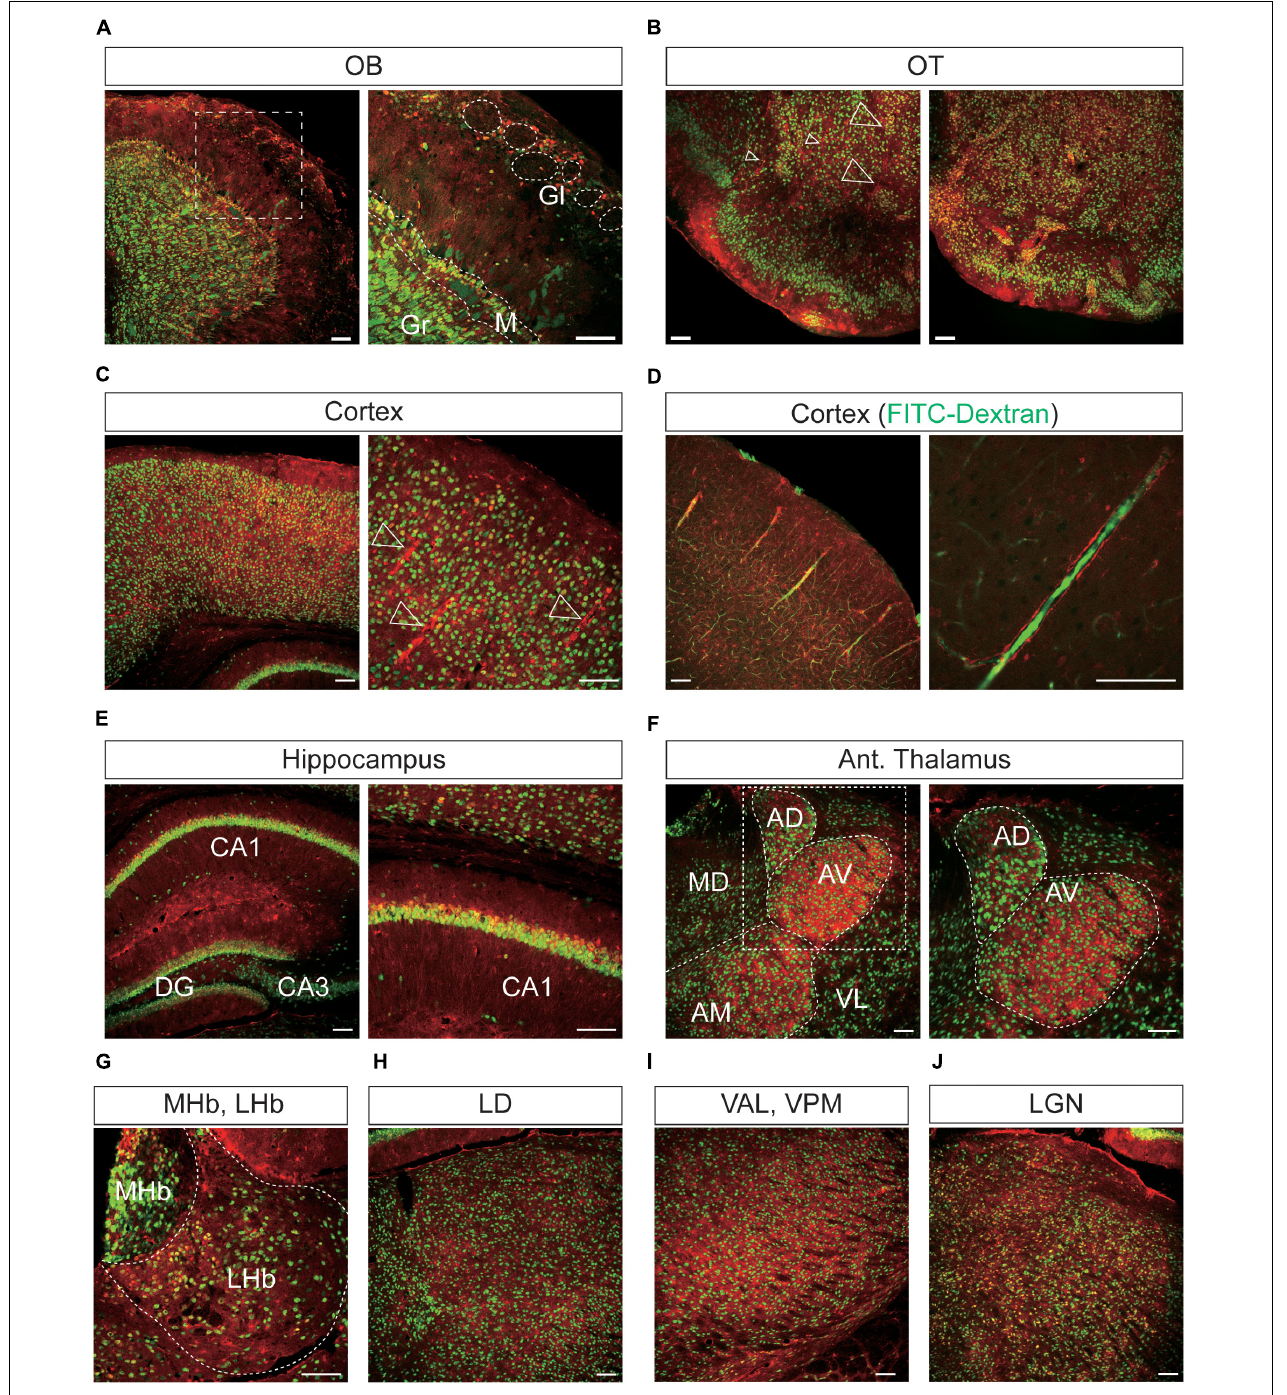
FIGURE 6 | Representative confocal images showing tdTomato fluorescence in the olfactory bulb, cerebral cortex, and thalamus of T1r2 -tdTomato mice. (A) Olfactory bulb (OB). Glomeruli (Gl), mitral layer (M), and granular layer (Gr) are indicated with white dotted lines, (B) olfactory tubercle (OT), (C) cortex, (D) cortex. FITC-Dextran (green). (E) In the hippocampus, Cornu Ammonis area 1 (CA1), CA3, and the dentate gyrus (DG) are labeled. (F) Anterior thalamus. Left : Anterodorsal (AD), anteroventral (AV), anteromedial (AM), mediodorsal (MD), and ventrolateral (VL) nuclei are labeled; Right : magnified images of the white dotted box in the left image, (G) medial (MHb) and lateral habenula (LHb), (H) laterodorsal nucleus (LD) of the thalamus, (I) ventroanterolateral (VAL) and ventroposterior medial (VPM) nuclei of the thalamus, and (J) lateral geniculate nucleus (LGN). White dotted lines indicate the borders of nearby areas. White empty triangles indicate vascular structures. Anti-NeuN signals [green except for panel (D) ]; tdTomato (red). Scale bar, 100 µ m.